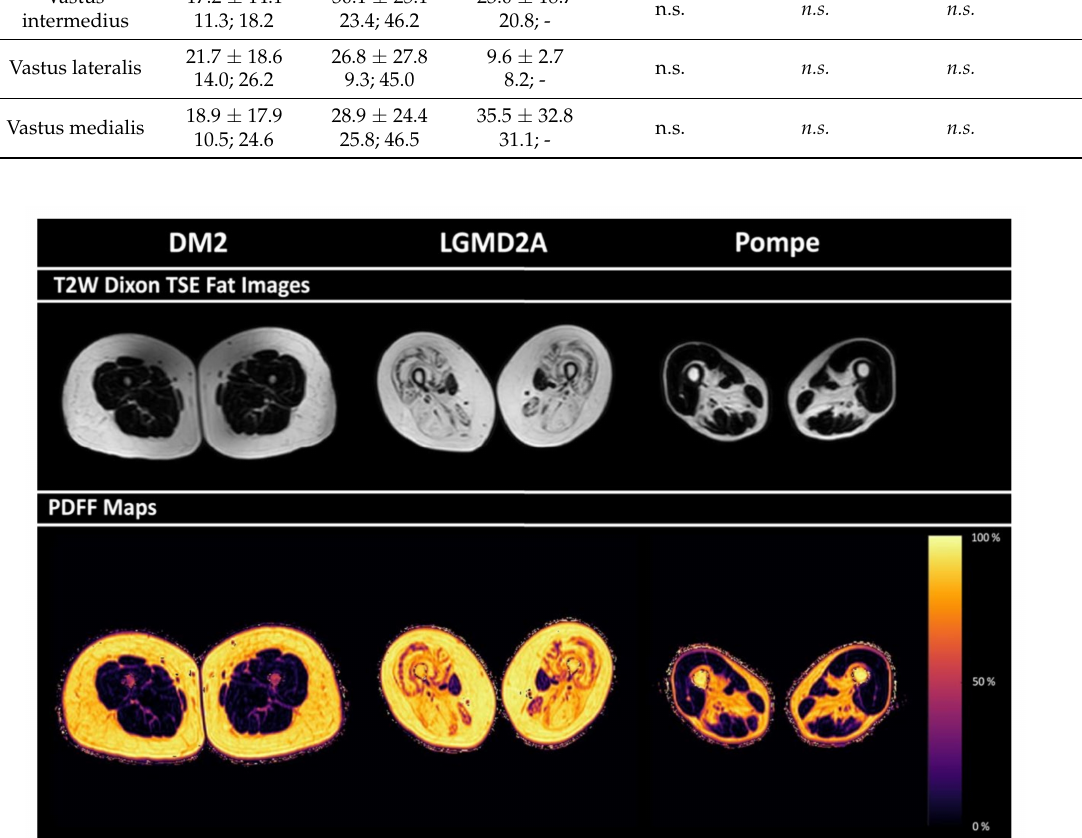
Figure 2. Representative T 2 -weighted DIXON turbo spin echo (TSE) fat images and proton density fat fraction (PDFF) maps for patients with myotonic dystrophy type 2 (DM2), limb girdle muscular dystrophy type 2A (LGMD2A), and Pompe disease. Disease-characteristic patterns of fatty infiltration are